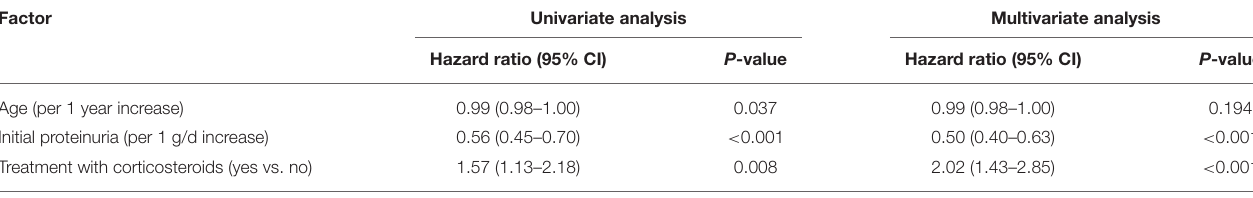
TABLE 3 | Univariate and multivariate analyses of independent prognostic factors of complete remission. Factor